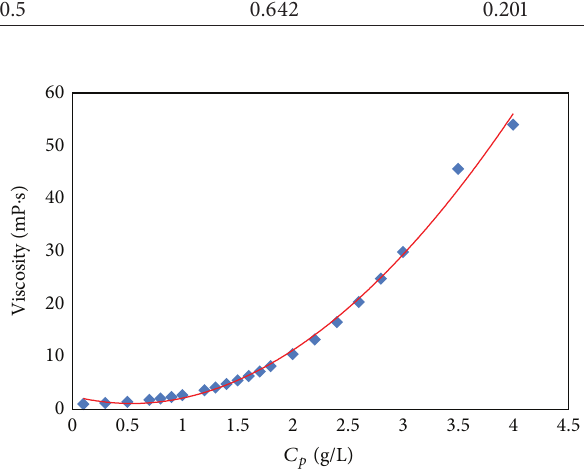
Figure 1: Relationship between polymer viscosity ( 𝜇 0 𝑝 ) and polymer concentration ( 𝐶 𝑝 ) at 75 ∘ C under 0.01 s −1 shear